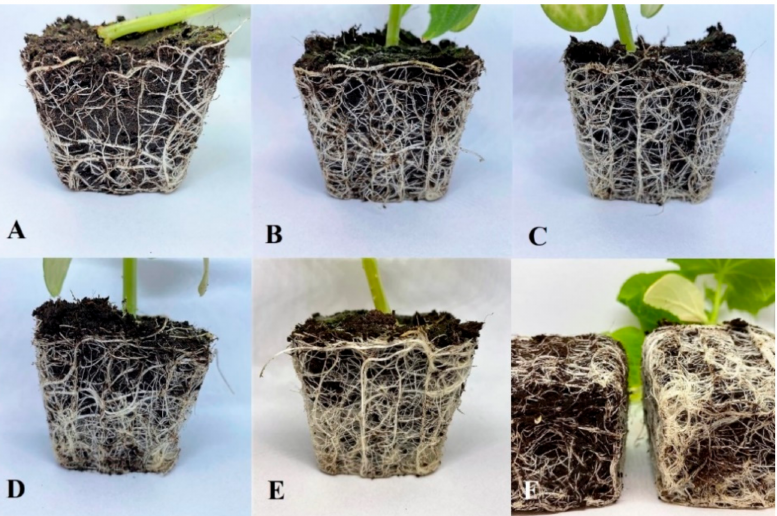
Figure 6. Root ball arrangement in pots for S1 ( A ), S5.1 ( B ), S5.2 ( C ), S5.3 ( D ), S5.4 ( E ), and S1 and S5.4 ( F ) (S1—Uncoated seeds, S5.1—Seed coating containing a solution of 2% alginate with amino acids (37.6 mL/100 g), micronutrients (37.5 mL/100 g), and NPK, S5.2—Seed coating